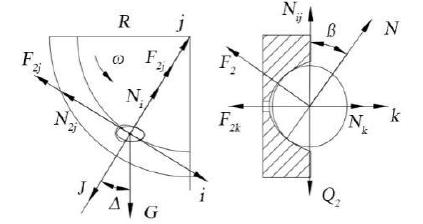
Figure 11. Analysis of the forces on the seed unloading area: Q 2 is the combined force of J and G , N ; Δ is the angle of the seeding position, °.